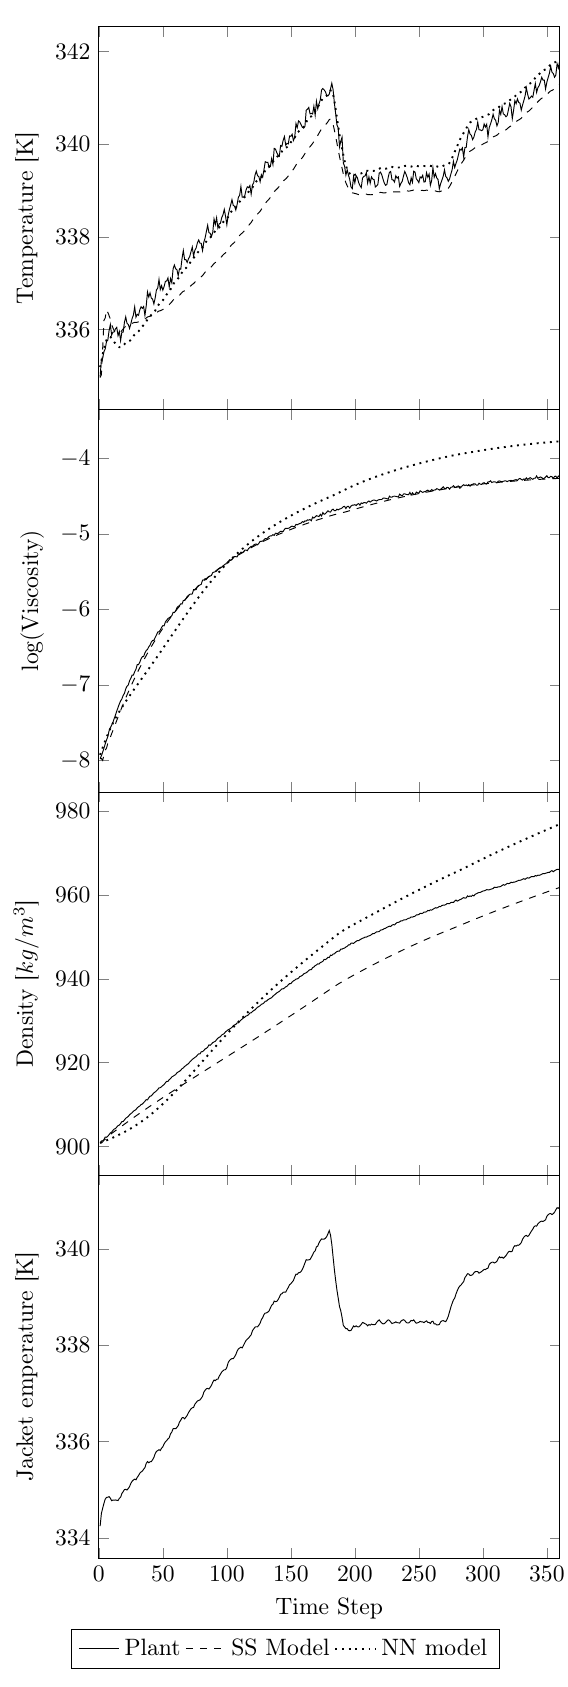
Figure 4. Validation of state-space models and NARX networks subject to measurement